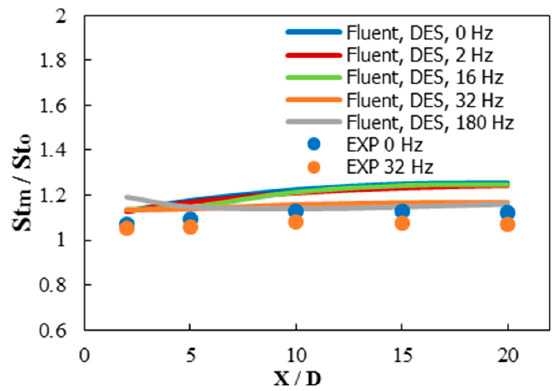
Figure 41. The spanwise-averaged Stanton number ratio obtained using the DES Realizable k - ε model for M = 0.5 for the 0, 2, 16, 32, and 180 Hz oscillations.